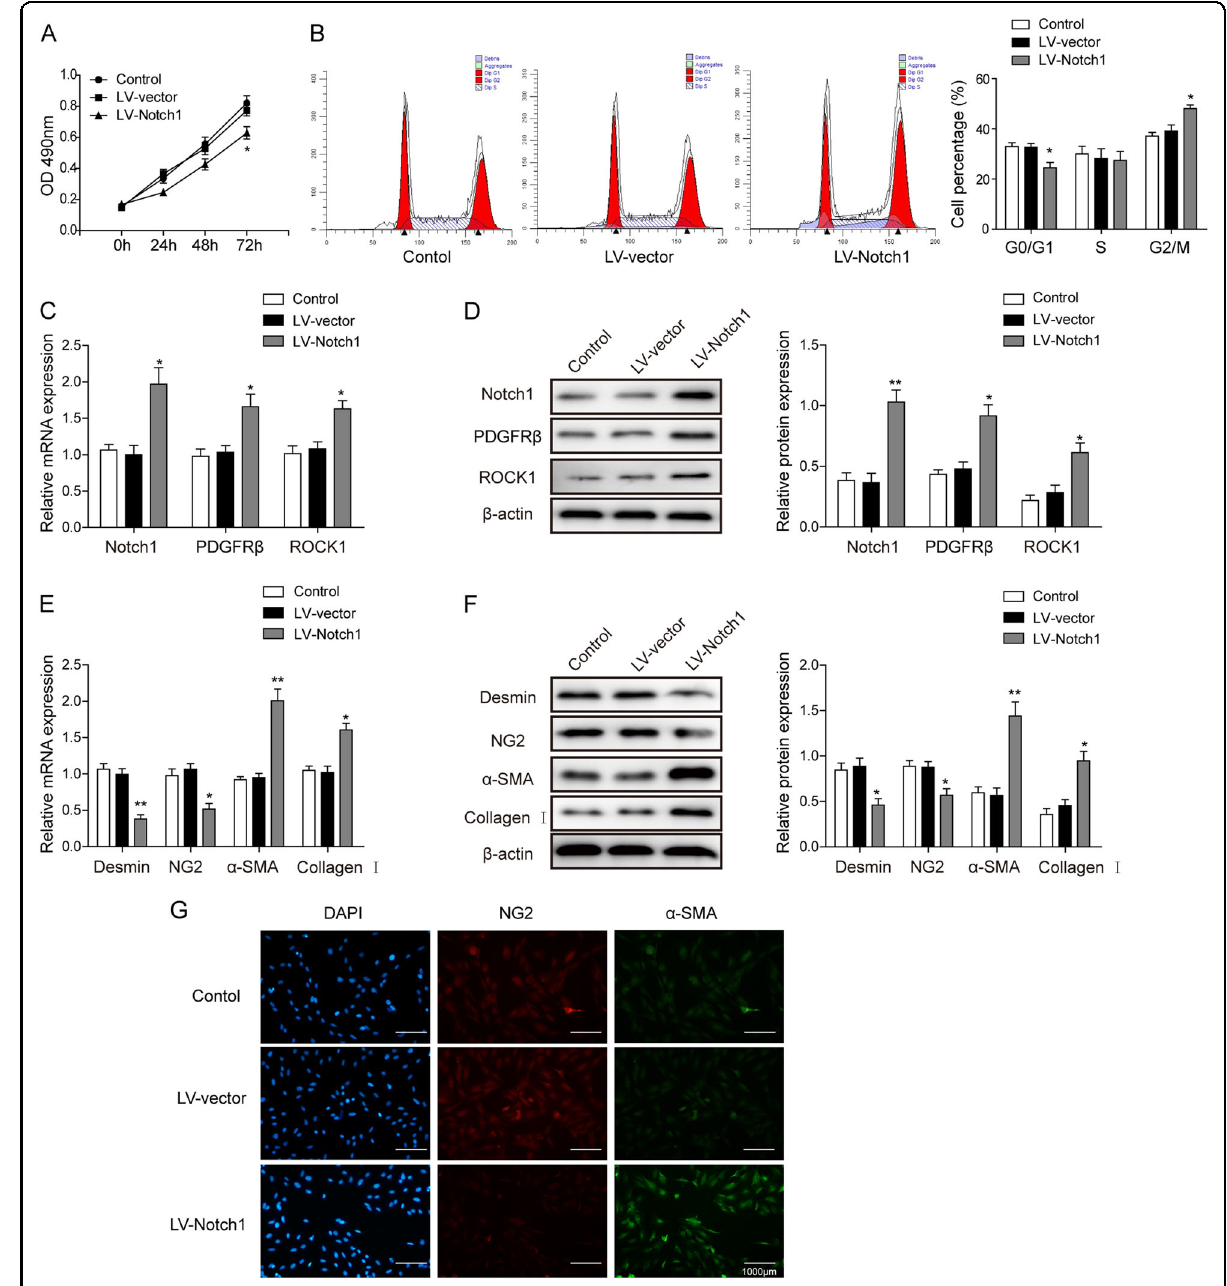
Fig. 2 Notch1 mediates pericyte proliferation and differentiation. a MTT assay of the pericyte cell viability after transfection with the lv-vector and lv-Notch1, compared with that of the control cells. b Flow cytometry for the cell cycle analysis of pericyte cells. c Relative mRNA expressions of the Notch1, PDGFR β , and ROCK1 proteins in control, lv-vector, and lv-Notch1 cells. d Western blot analysis showing the protein levels of Notch1, PDGFR β , and ROCK1 in control, lv-vector, and lv-Notch1 pericyte cells. e Relative mRNA levels for desmin, NG2, α -SMA, and collagen I genes in control, lv-vector, and lv-Notch1 pericyte cells. f Western blot analysis showing the protein levels of desmin, NG2, α -SMA, and collagen I in control, lv- vector and lv-Notch1 pericyte cells. g Immuno fl uorescent staining for cell surface markers indicating pericyte differentiation. The means ± SD in the graph present the relative levels from three replicates. * p <